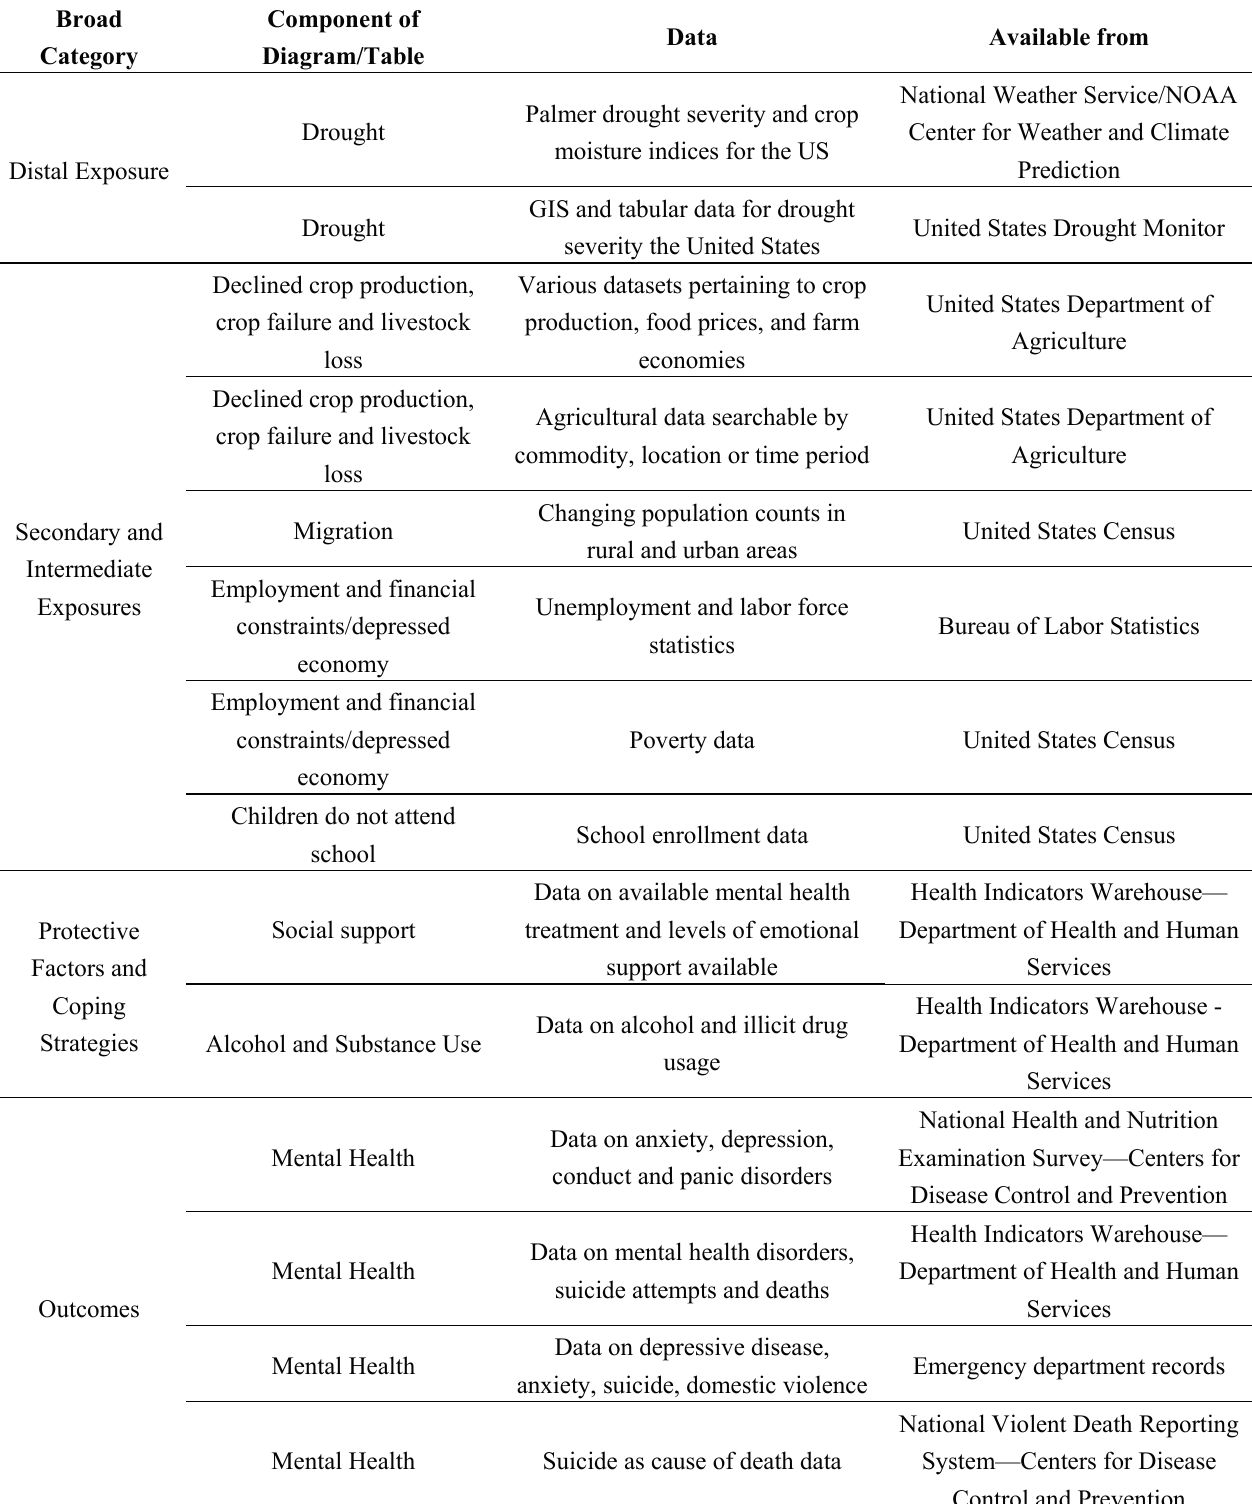
Table 3. Suggested Data Sources for Future